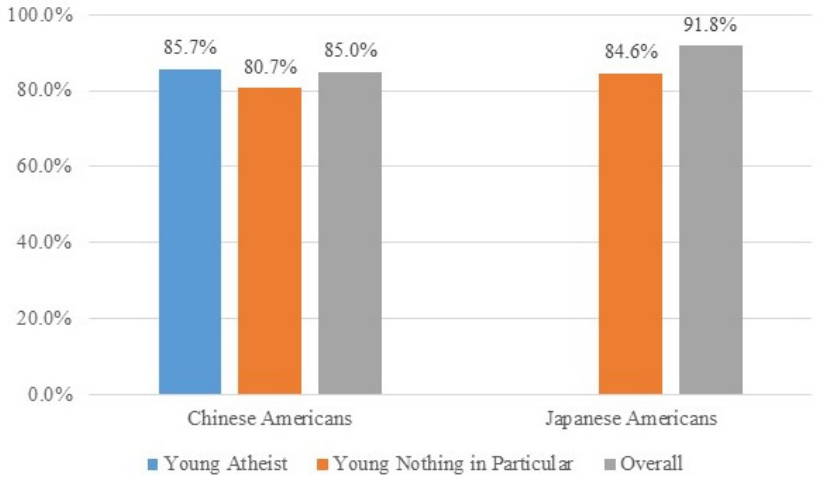
Figure 17. Getting along with